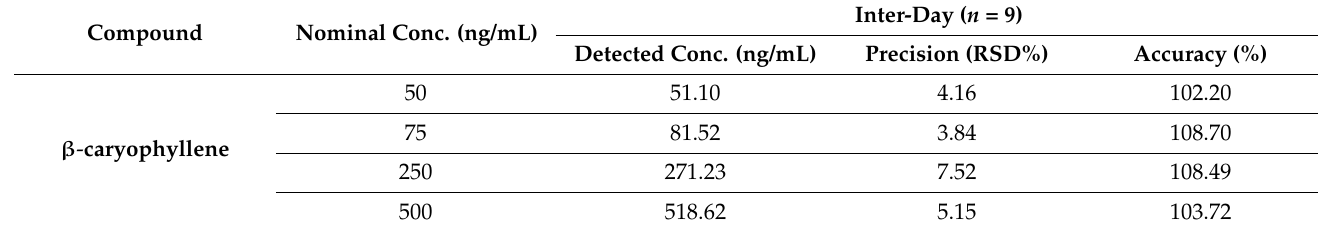
Table 2. Inter-day assays of